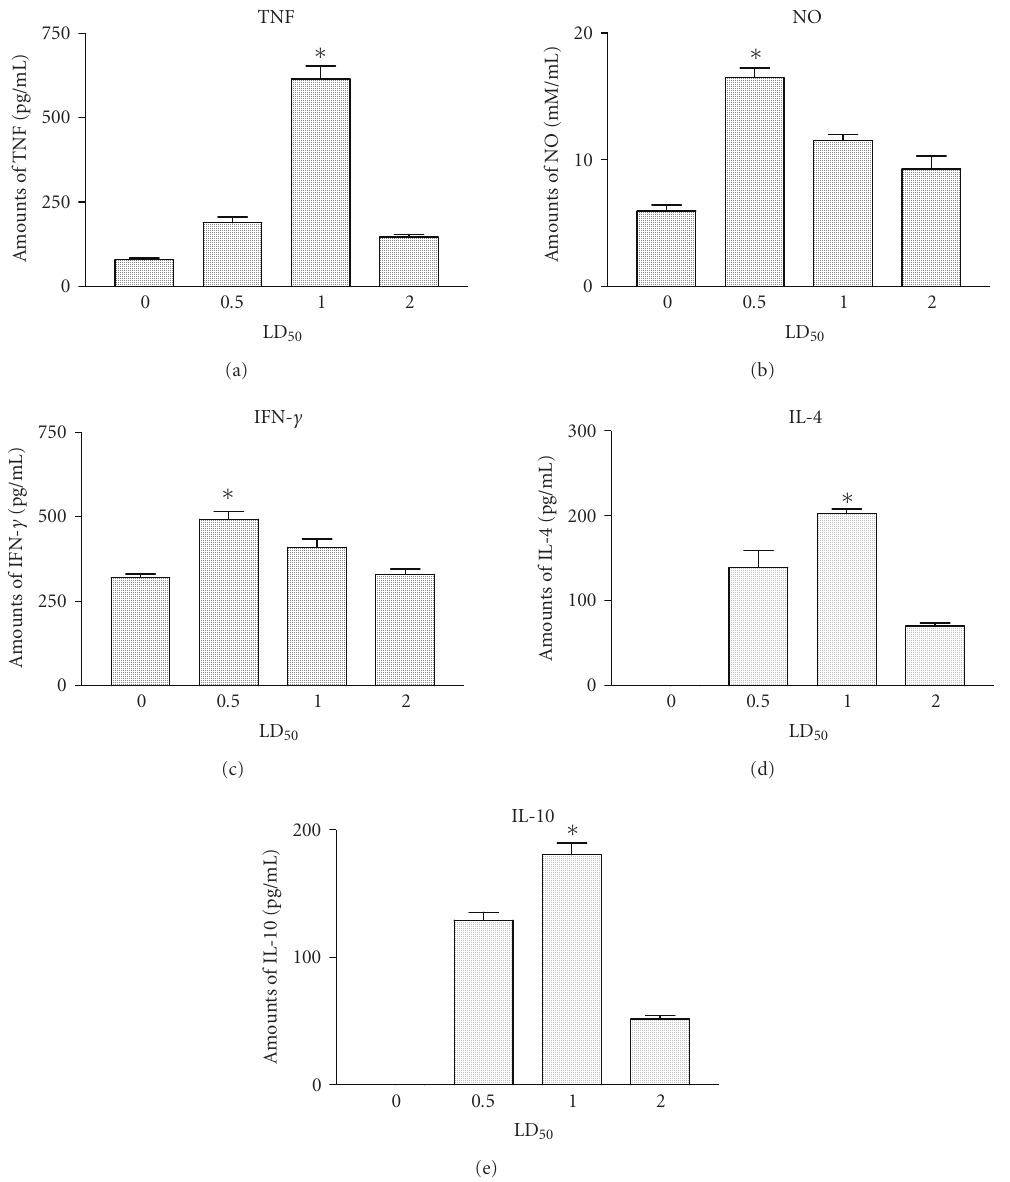
Figure 5: Mediators secretion . Groups of BALB/c female mice with 13–15 g were i.p. injected with 0.5, or, 1 and/or 2 LD 50 of Cdt, after 2 hours, the animals were bled and the levels of cytokines and NO present in the serum were determined as described in materials and methods (see Section 2). Each point represents the mean value of the results obtained from two independent experiments conducted with five to fifteen animals each. Statistical di ff erences between the injections were marked with asterisk ( P < 0 .